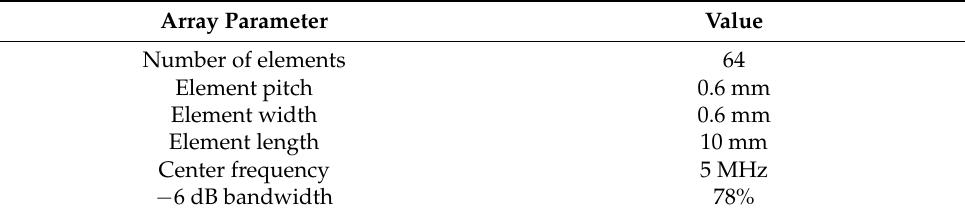
Figure 4. The geometry of oblique incidence situation for simulation. Table 1. The parameters of the phased array used in the simulation and experiment.